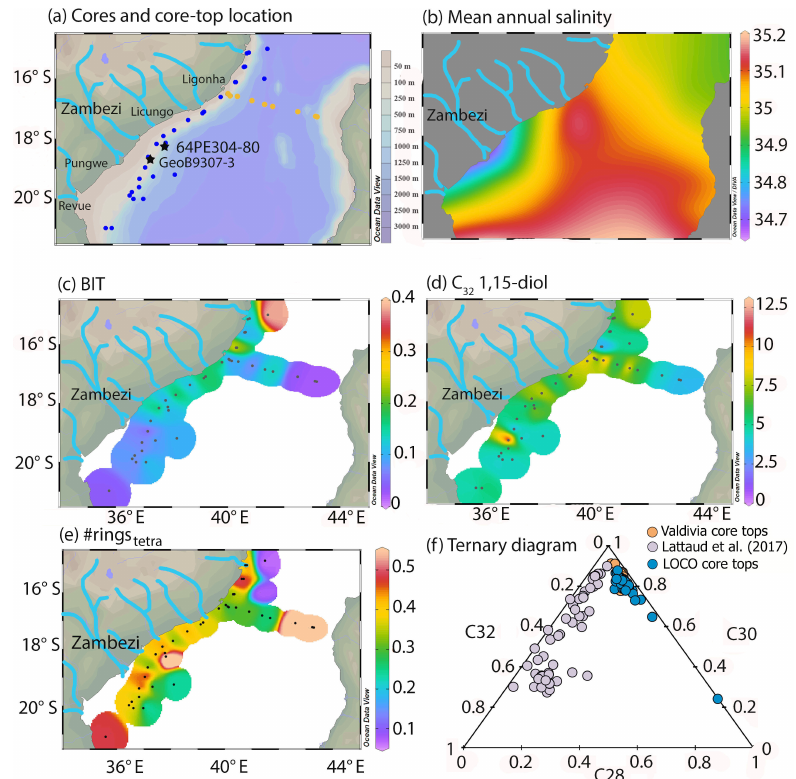
Figure 1. Map presenting (a) the location of the core tops (LOCO (LOng COres) transect in orange; VA (R/V Validivia expedition) core tops in blue) and cores (stars), (b) the mean annual salinity, from NOAA 1 × 1 ◦ grid (http://iridl.ldeo.columbia.edu), (c) the BIT index (LOCO transect values; VA core tops from this study), (d) F C321 , 15 in the core tops, (e) #rings tetra of the surface sediments (#rings tetra as defined by Sinninghe Damsté, 2016), (f) ternary diagram of C 28 (sum of C 28 1,13 and C 28 1,14), C 30 (sum of C 30 1,13, C 30 1,14 and C 30 1,15), and C 32 (C 32 1,15) diols (LOCO transect in orange; VA core tops in blue; data from Lattaud et al., 2017, in purple). The maps were drawn using Ocean Data